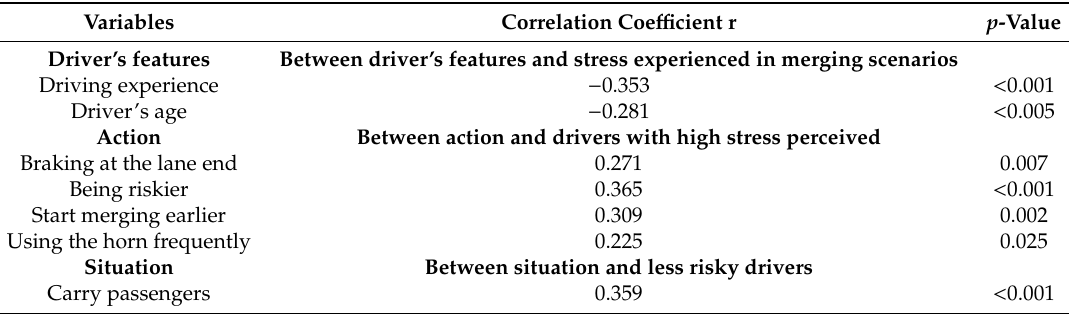
Table 1. Correlation coe ffi cient between